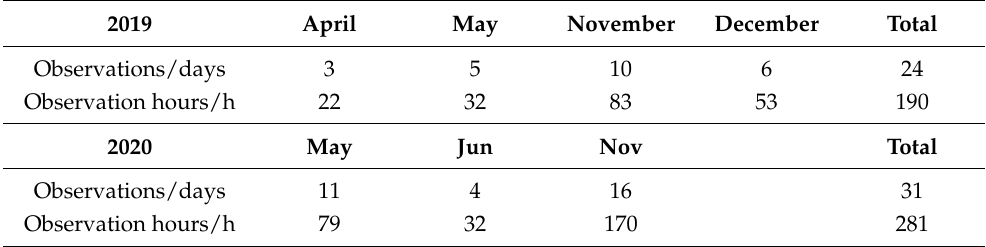
Table 2. Statistics of the temperature